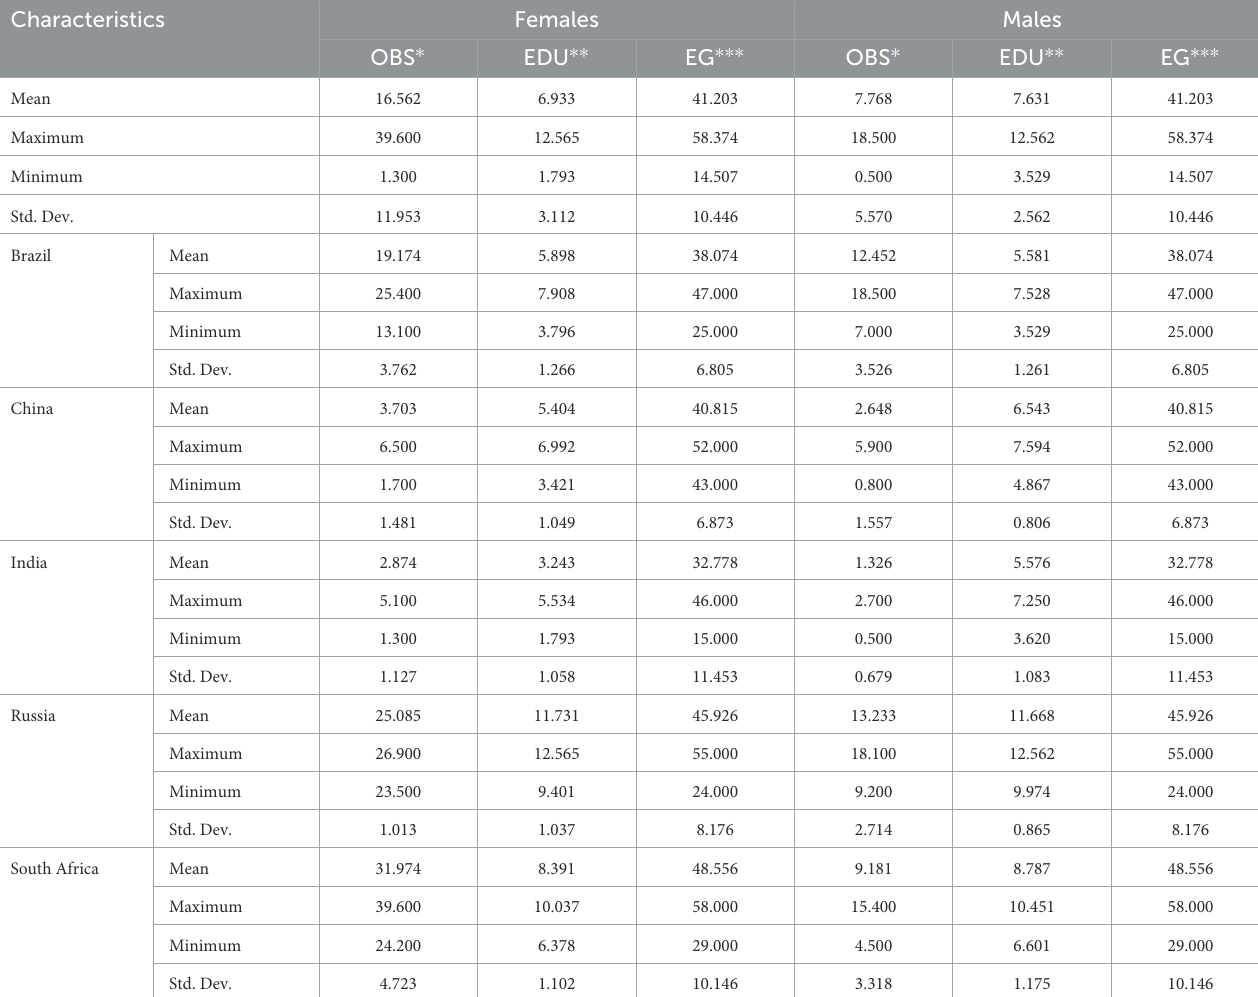
TABLE 3 Main characteristics of the variables.